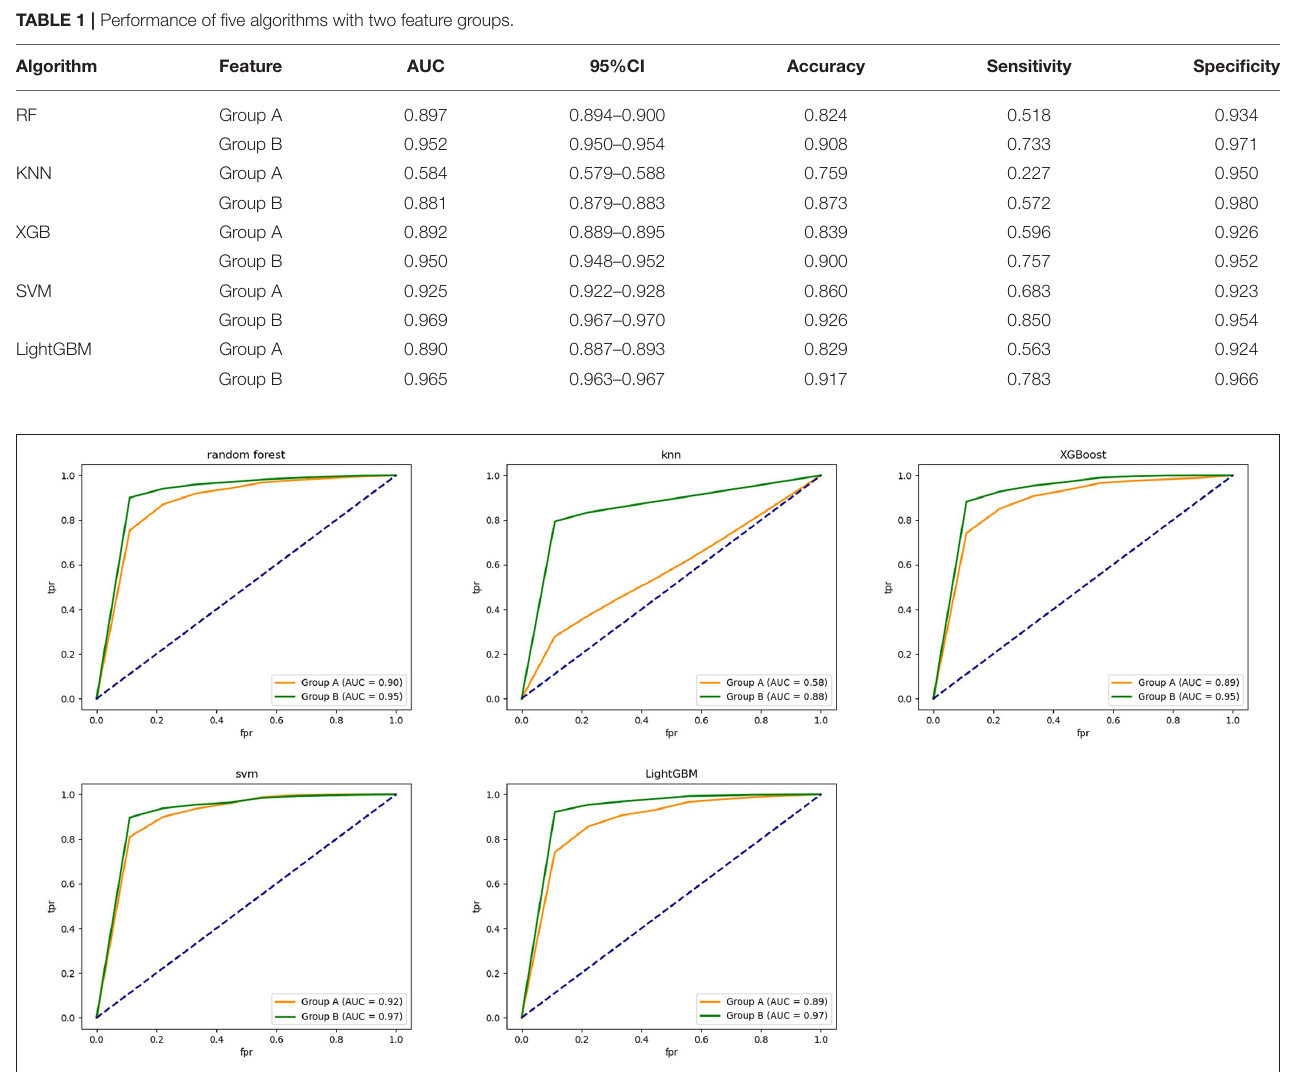
FIGURE 7 | The ROC curve of five classification models established using different ML